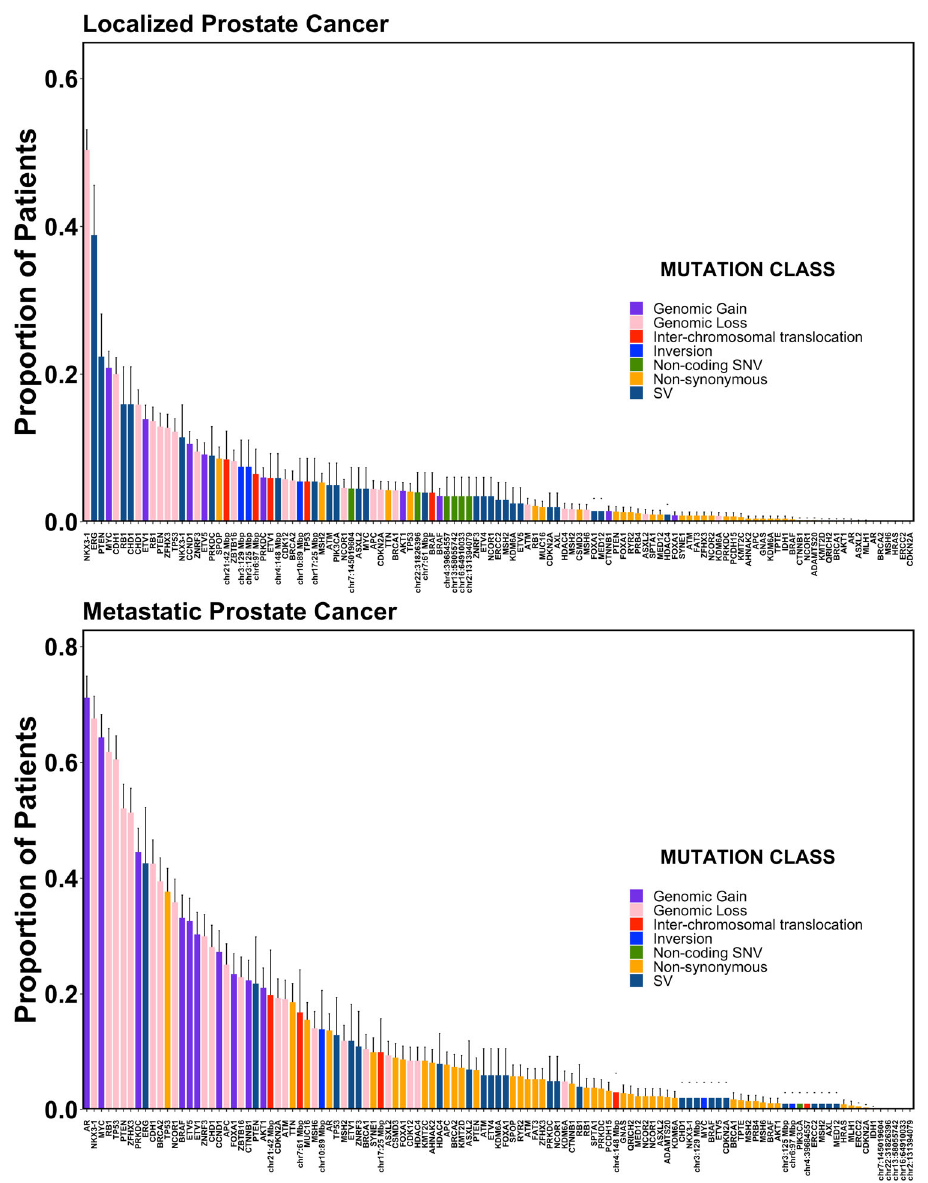
Fig. 1 Frequency distribution of genes affected by driver mutations in prostate cancer. The full cohort ( n = 1844) was split into localized ( n = 1289) and metastatic ( n = 555) disease. Estimated proportion of patients in each cohort harboring each of 113 speci fi c driver mutations. X -axis indicates the gene or genomic locus affected. Bar color indicates the type of driver mutation affecting that gene. Several genes are affected by multiple mutation types (e.g. TP53 , PTEN , and others). Bars show the proportion of patients harboring the indicated mutation. Error bars represent 95% con fi dence intervals. Centre of the error bars represent the observed proportion. Source data are provided as a Source Data fi